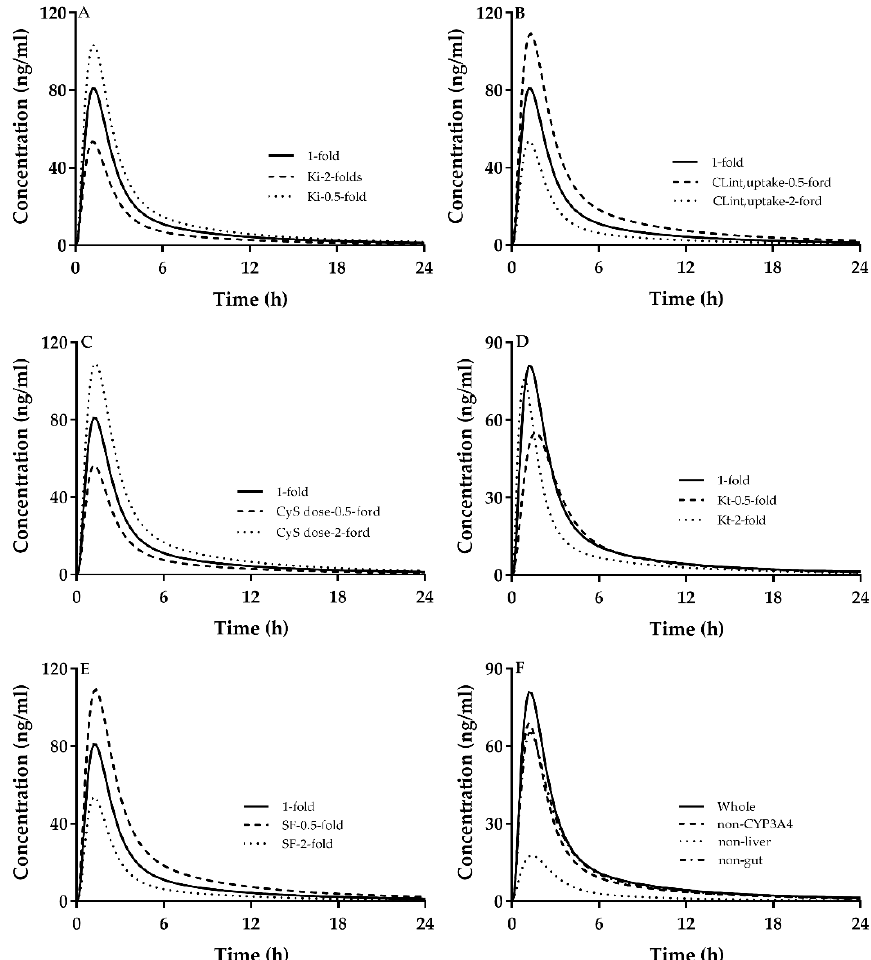
Figure 3. Contributions of ( A ) inhibition constant on hepatic organic anion transporting polypeptides (OATP) by CsA (K i,OATP ), ( B ) OATP-mediated hepatic uptake (CL int,up ), ( C ) CsA dosage (100 mg, 200 mg and 400 mg), ( D ) transition rate (K t ) and ( E ) empirical scaling factor (SF) to plasma concentrations of atorvastatin following oral 40 mg of atorvastatin. CsA dosage was set to be 200 mg/d. Contributions of ( F ) inhibitions on CYP3A4 (non-CYP3A4), integrated effects of hepatic CYP3A-mediated metabolism/hepatic OATP-mediated uptake (non-liver) and integrated effects of intestinal CYP3A4-mediated metabolism/transporter-mediated intestinal efflux (non-gut) to the increased plasma concentrations of atorvastatin by CsA. Table 7. Pharmacokinetics parameters of different factors on plasma concentrations of atorvastatin following 40 mg orally.